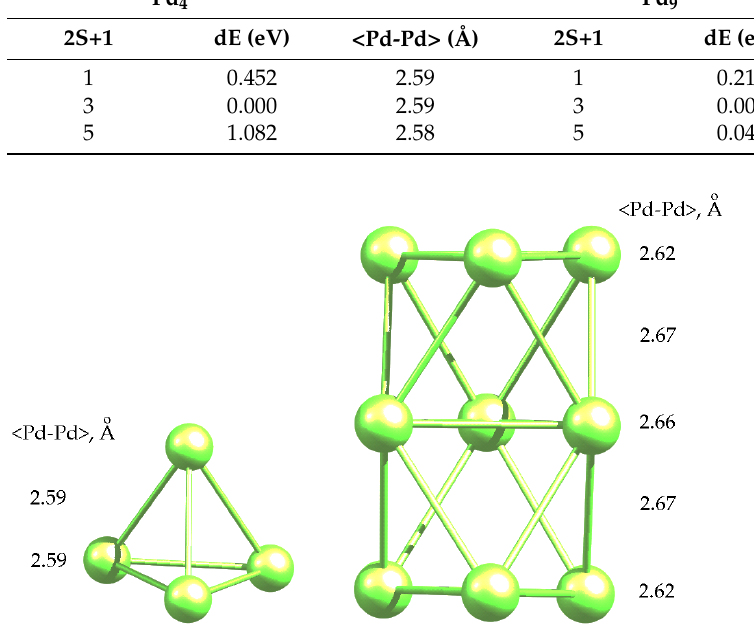
Figure 1. Optimized geometries of Pd 4 and Pd 9 clusters in a triplet state. As it can be seen, triplet was the ground state for both clusters, which is in good Table 1. Results of geometry and relative energy calculations for Pd 4 and Pd 9 . agreement with the literature data [40–43]. The average <Pd-Pd> bond lengths were 2.59 Å and 2.65 Å for Pd 4 and Pd 9 clusters, respectively. These values were used to estimate the changes in the bond lengths of clusters in adsorption complexes. It is noteworthy that in the structure of Pd 4 cluster, which was a slightly distorted tetrahedron, two mutually non-intersecting edges had a length of 2.55 Å, while all the other edges had a length of 2.61 Å. Obviously, such a distortion was due to the Jahn-Teller effect. In the case of BZ adsorption on Pd 4 clusters, the triplet was also shown to be the ground state (Table 2). Table 2. Relative energies of Pd 4 *C 6 H 6 and the energy of BZ adsorption on Pd 4 for different